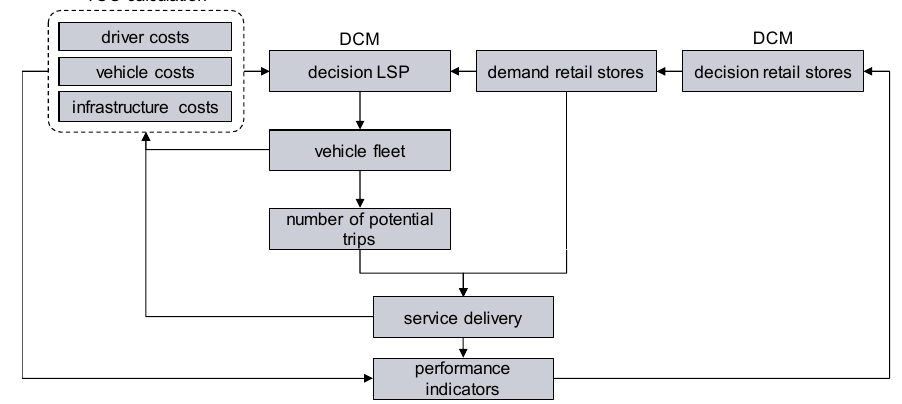
Figure 1. Causal loop diagram resulting from the CIA.